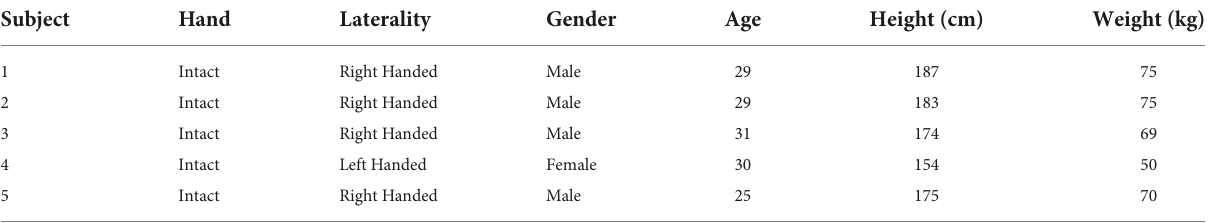
TABLE 1 Subject attribute information of NinaPro DB2